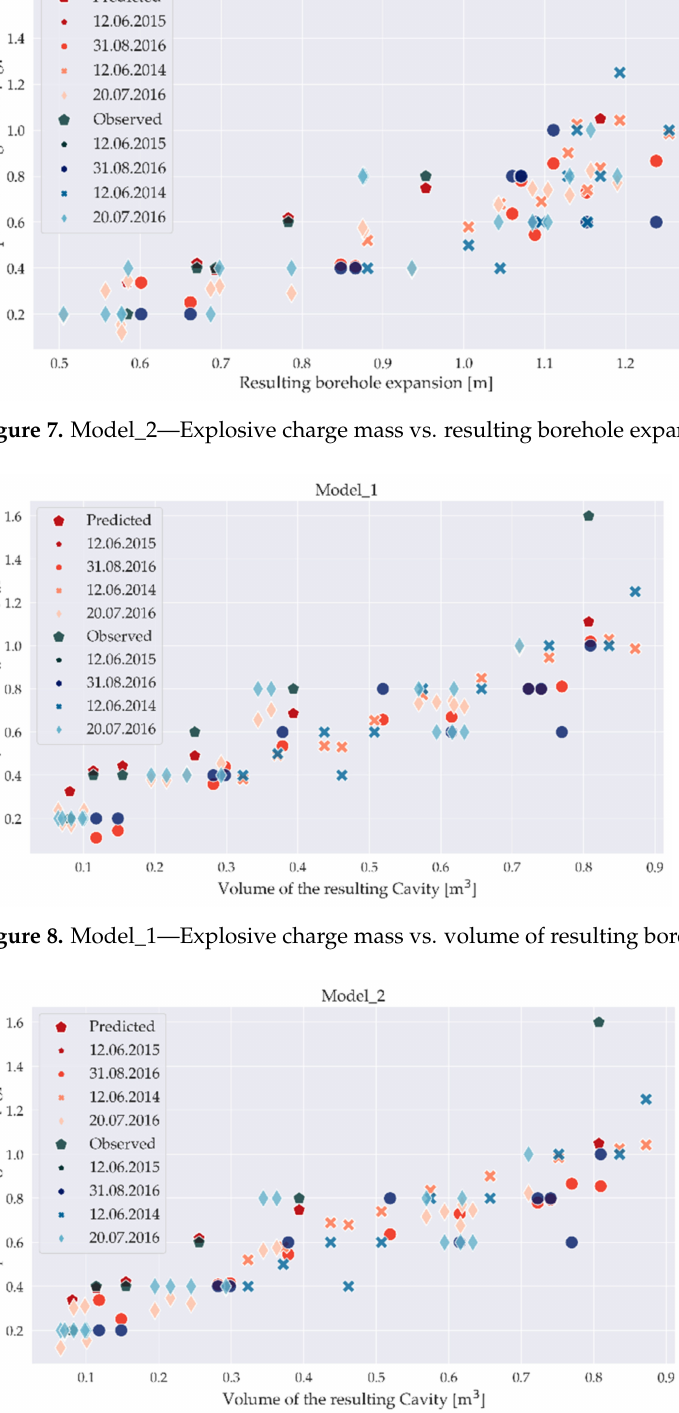
Figure 9. Model_2—Explosive charge mass vs. volume of resulting borehole